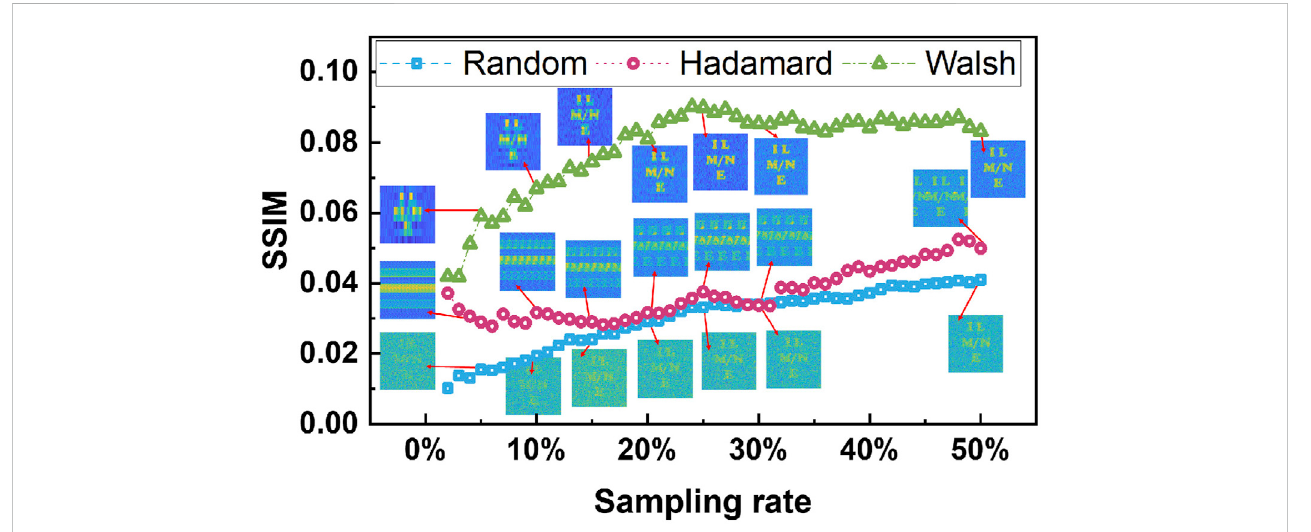
FIGURE 5 Simulated results of SSIM indicator vs . sampling rates of laser GI based on random, Hadamard, and Walsh speckle patterns at the 1% noise environment.